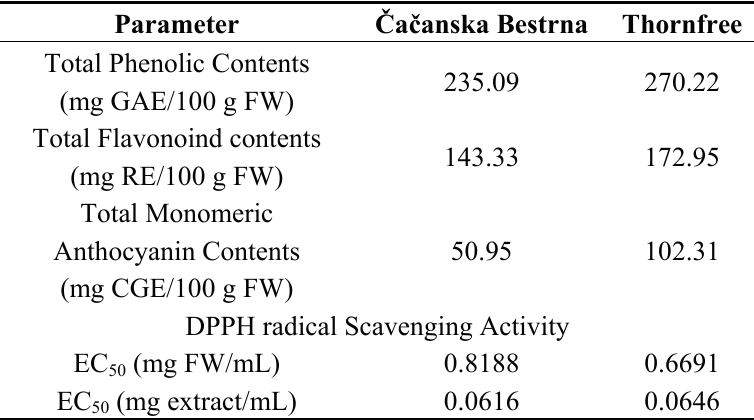
Table 14. Total phenolic, flavonoid and monomeric anthocyanin contents and antioxidant activity two blackberry cultivars [31].